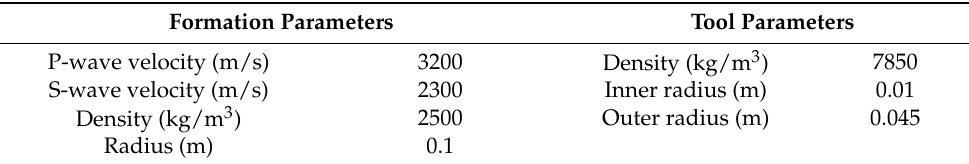
Table 2. Parameters of simulated formation and tool.